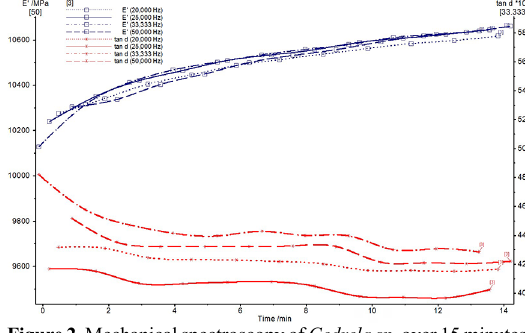
Figure 2. Mechanical spectroscopy of Cedrela sp . over 15